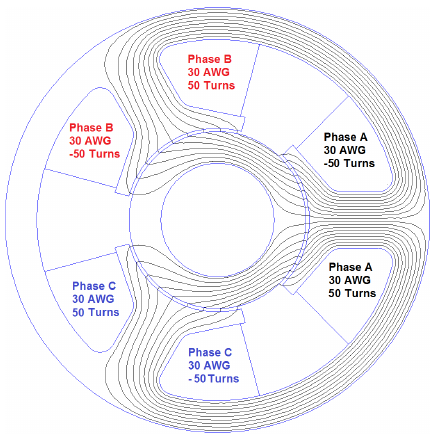
Figure 1. Small three-pole bearing with 0.25 inch rotor outer diameter.